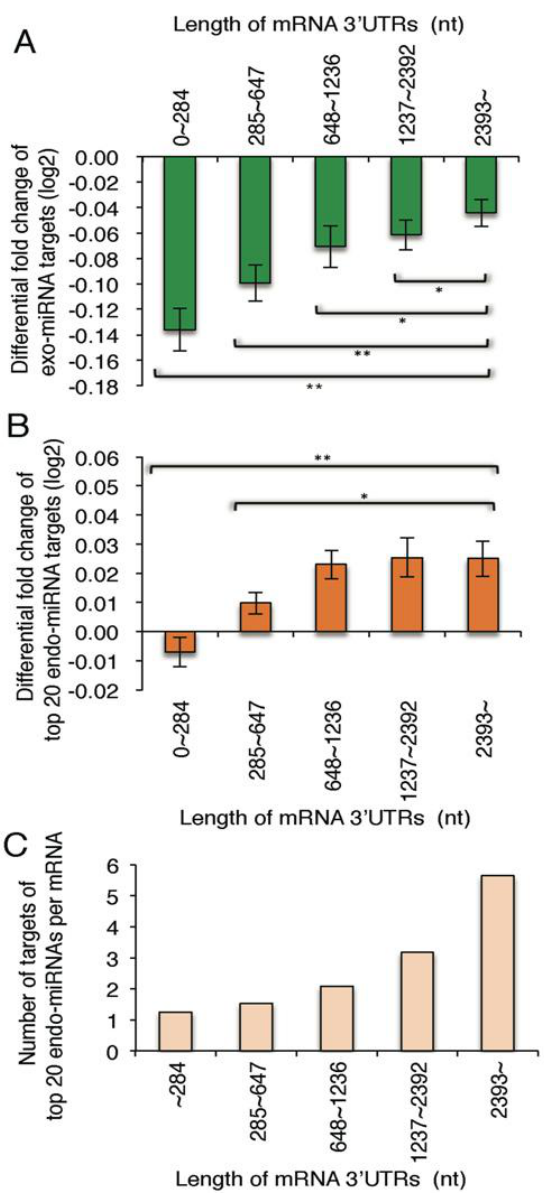
Figure 5. Mean fold changes of target genes of exo-miRNAs and endo-miRNAs according to the 3' UTR lengths. Differential fold changes (log ) of expression levels of exo-miRNA 2 targets ( A ); and endo-miRNA targets ( B ); and the number of top 20 endo-miRNA target sites ( C ) according to the lengths of 3' UTRs. The averaged numbers of exo-miRNA target sites are 53, 137, 210, 250 and 149 ( A ), and those of endo-miRNA target sites are 53, 134, 185, 184 and 84 ( B ) in the 3' UTRs of 0–284, 285–647, 648–1236, 1237–2392 and 2393~nucleotides (nts). Each fraction contains the same number of mRNAs registered in the RefSeq